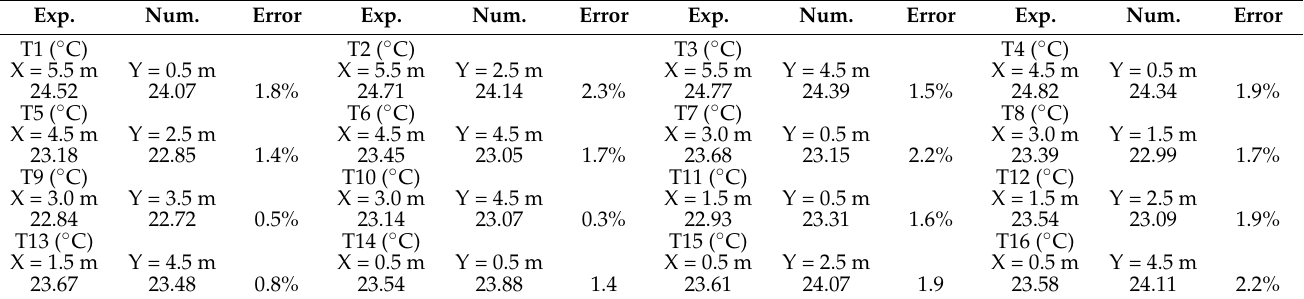
Table 3. Comparisons of air temperatures inside the classroom, experimentally measured and numerically obtained.